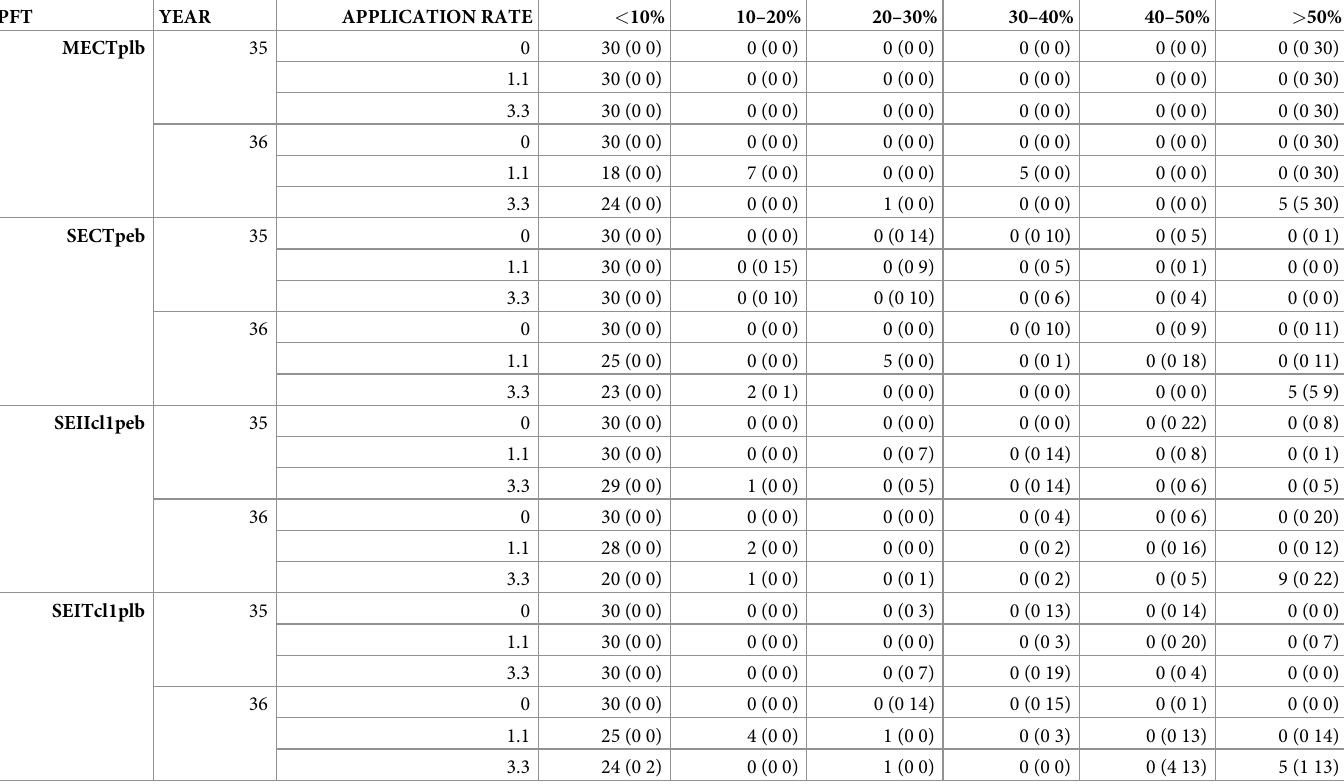
Table 6. Number of weeks in which the mean (minimal and maximal) negative effect on population size is within a certain effect class for two different PFTs. As IBC-grass simulates only 30 weeks of growing period, the maximal number of weeks is 30. Simulated herbicide application started in year 36. Herbicide application rate of 1.1 g a.i./ha represents herbicide scenario 1 and the application rate of 3.3 g a.i./ha represents herbicide scenario 2. Numbers in brackets represent the number of weeks in which the minimal and maximal values are within a certain effect class. Please note, that only negative effects are considered in this table. Positive impacts can be observed in Figs